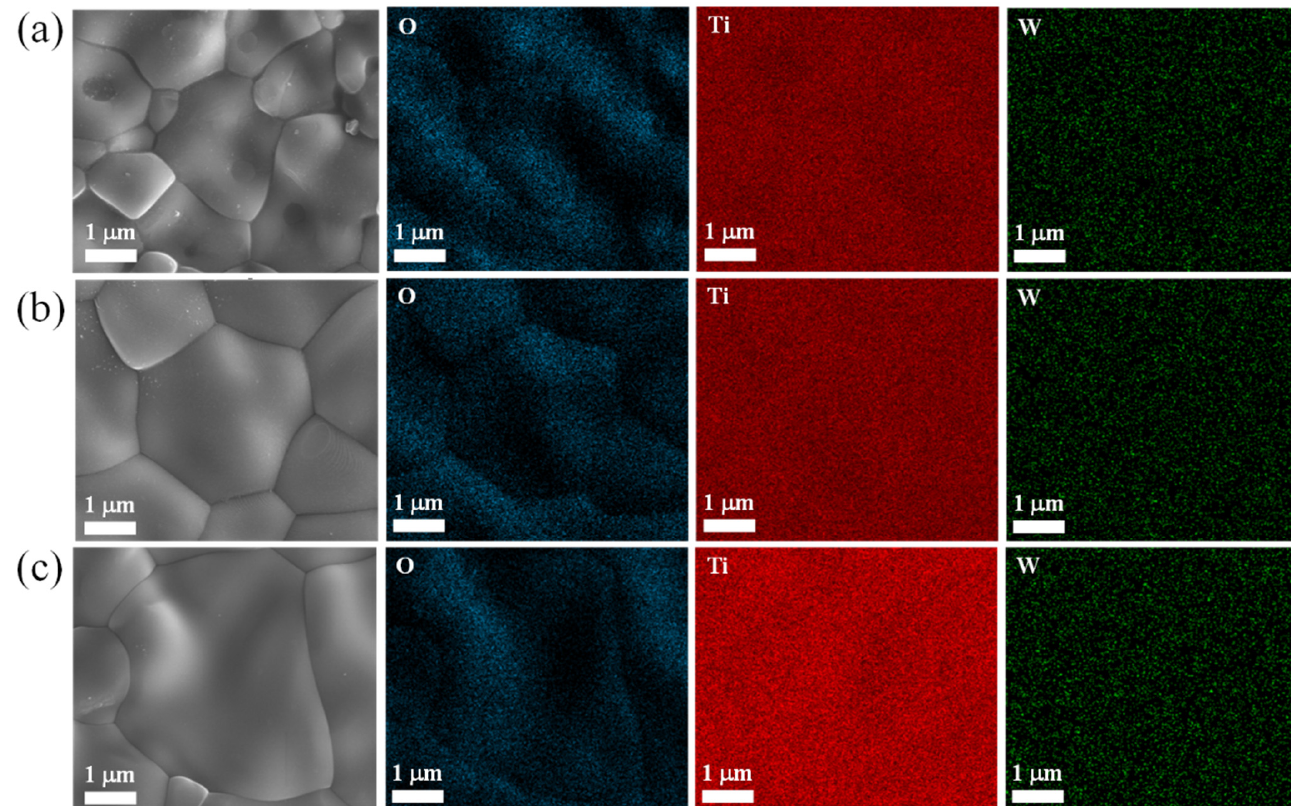
Figure 3. SEM-EDS mapping of the ( a ) 2.5%WTO-1400, ( b ) 0.25%WTO-1500, and ( c ) 2.5%WTO-1500 ceramics.